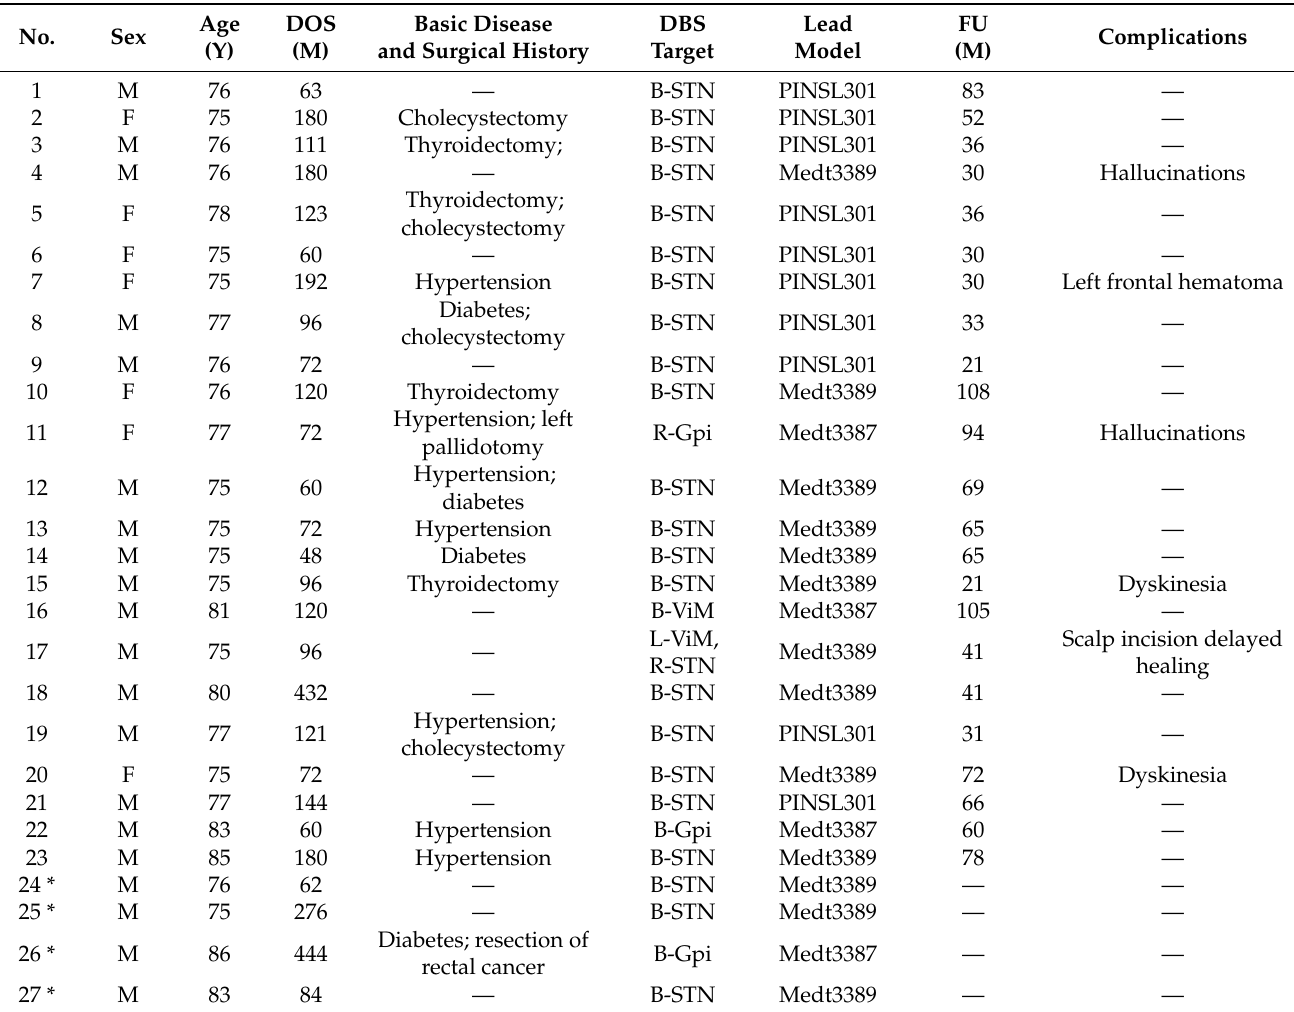
Table 1. Clinical characteristics of the 27 elderly PD patients ( ≥ 75 years old) treated with DBS